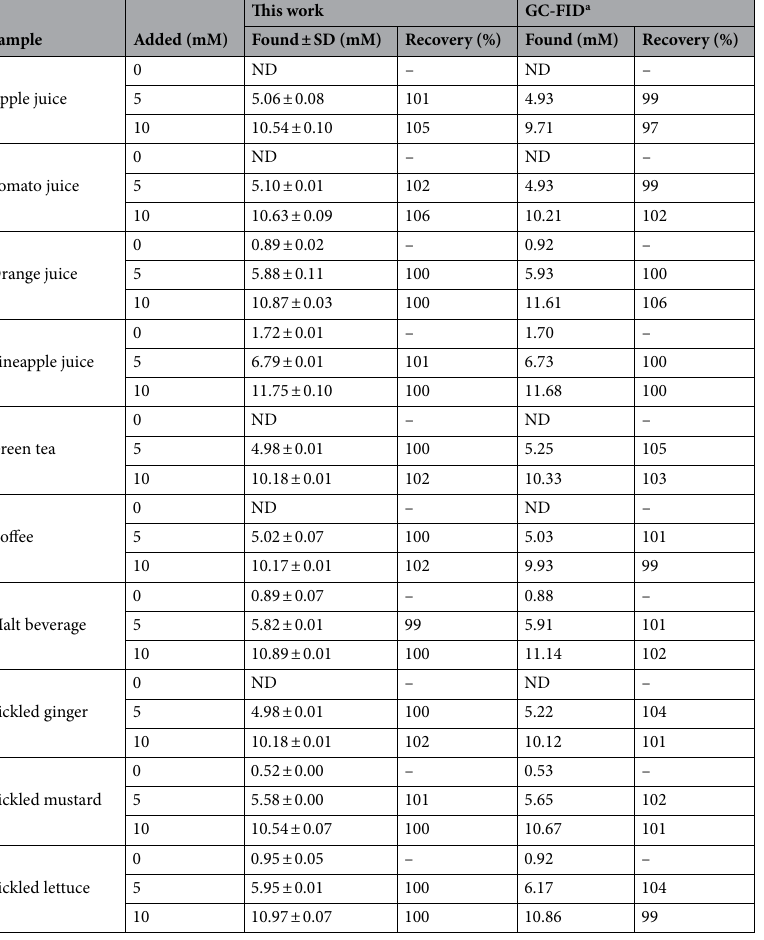
Table 2. Determination of methanol in fruit and vegetable beverages by the proposed method and reference method. a Food Research and Testing Laboratory, Faculty of Science, Chulalongkorn